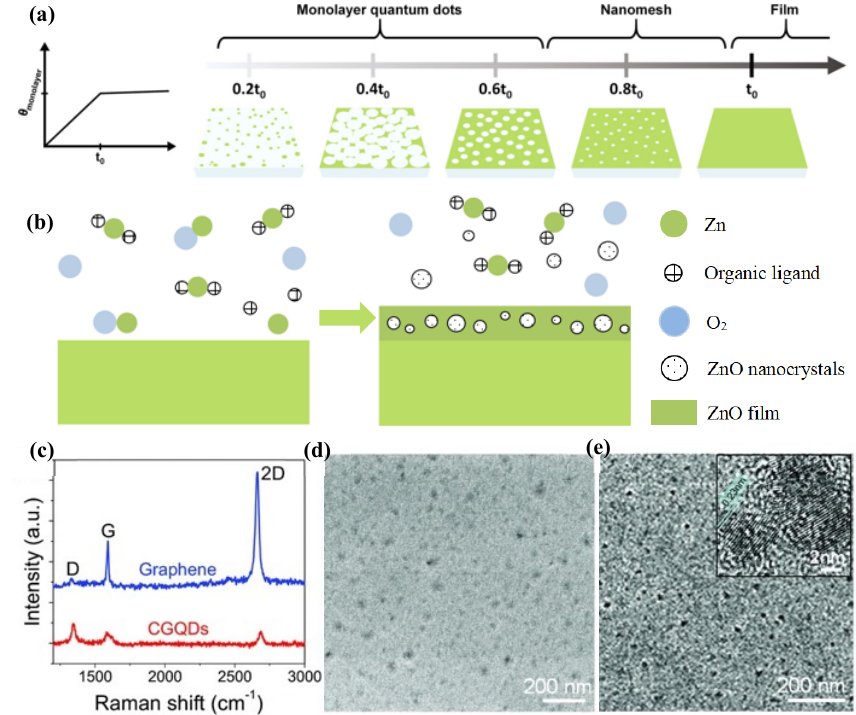
Figure 11. ( a ) Synthesis of the nanostructure of the nanomesh and QDs depending on the growth time [62]. Copyright 2022, Bulletin of the Korean Chemical Society. ( b ) Growth mechanism of the ZnO QD embedded film. Arriving of the precursors on the hot substrate. Pre-reaction of the precursors facilitates the formation of nanocrystals, and in turn incorporates into the ZnO film. ( c – e ) Structural characterizations of CGQDs. ( c ) Raman spectra. ( d ) SEM image. ( e ) TEM image. The inset shows the HRTEM image of two CGQDs [66]. Copyright 2013, Particle & Particle Systems Characterization .